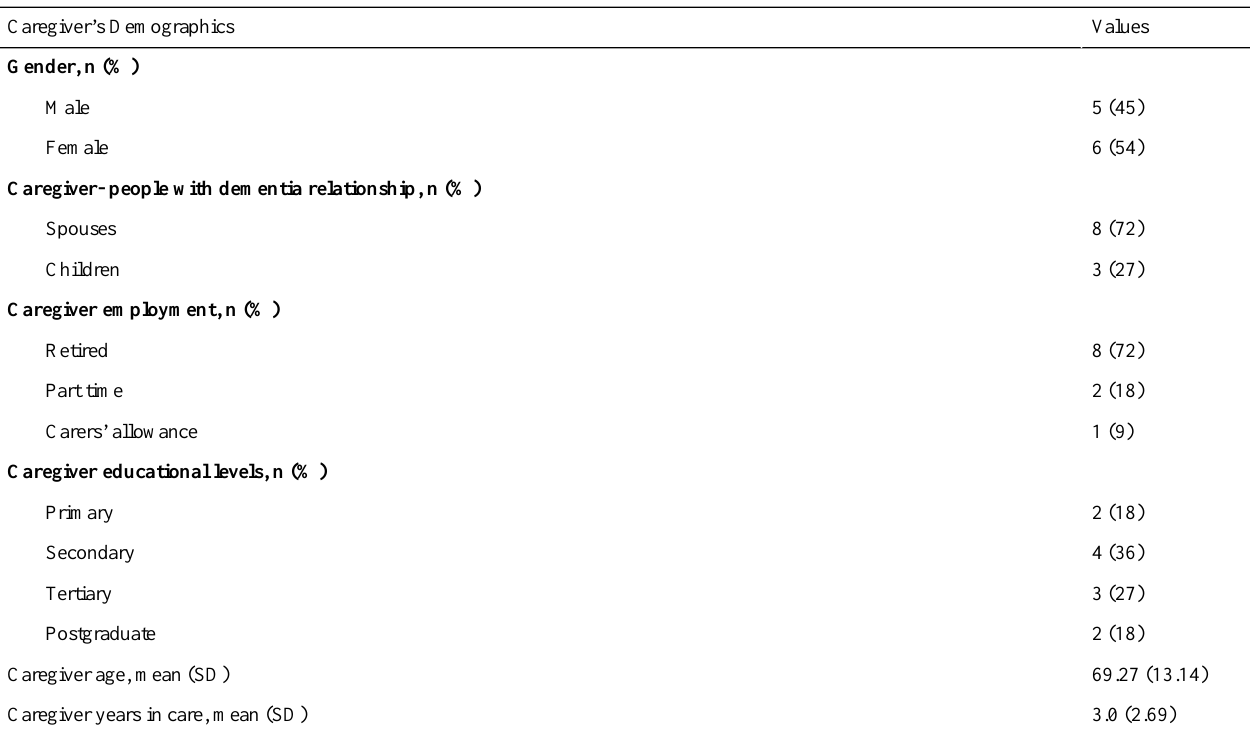
Table 5. Demographic characteristics of the informal caregivers involved in the year of follow-up